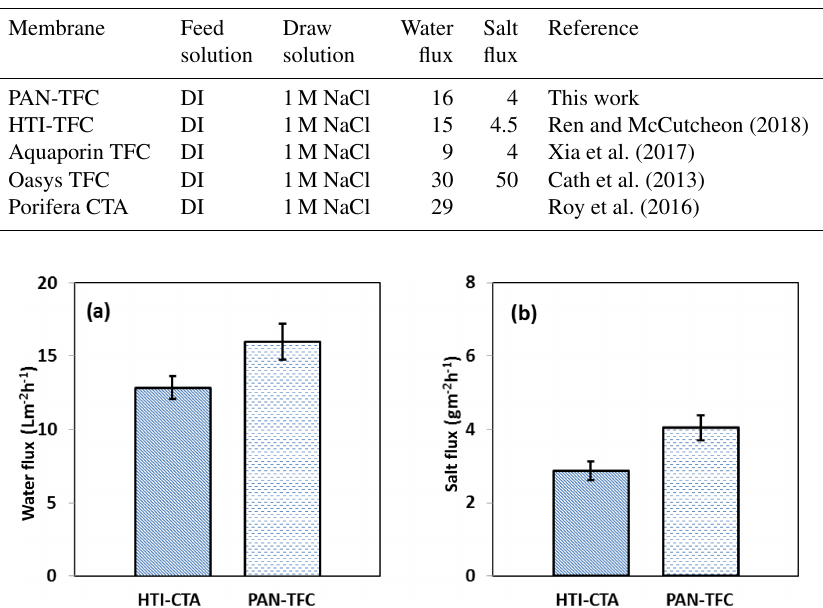
Figure 9. Forward osmosis (a) water flux and (b) salt flux for the PAN-TFC membrane. Experimental conditions: feed solution: DI water, draw solution: 1M NaCl, FO mode, volumetric flow rate of feed and draw 0.6Lmin − 1 , temp 25 ◦ C, zero transmembrane pressure. Results are an average of three experiments with different coupons. Error bars indicate standard